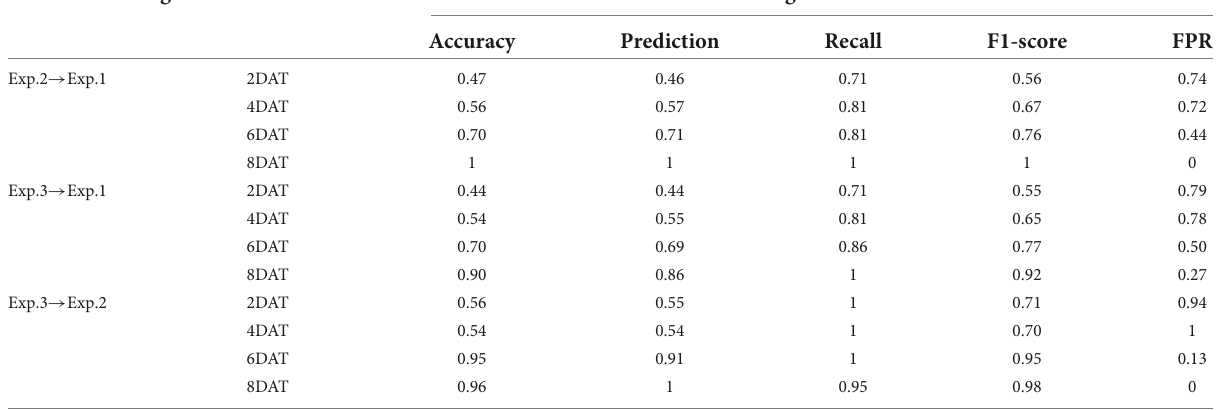
TABLE 3 Prediction results of transfer component analysis-based support vector machine models on target domain. Transfer learning task